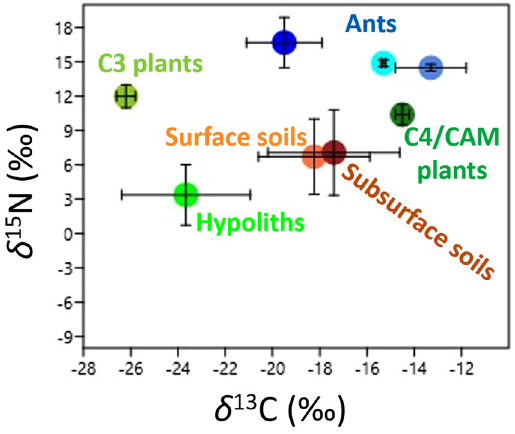
Figure 3. Bi-plot of mean ( ± SD) stable isotope compositions ( δ 13 C and δ 15 N; ‰) from Namib Desert biosystems. Plants and ants isotopic signatures were obtained from 41 . Outliers identified in Fig. 2 were excluded from the analysis.